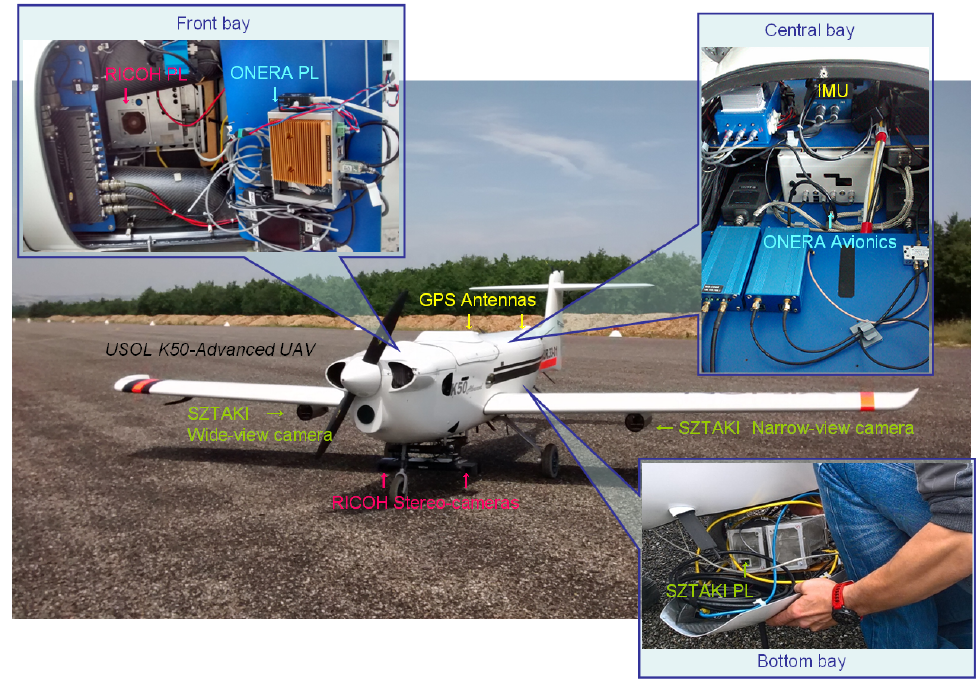
Figure 7. USOL (Spanish SME) K50 UAV experimental platform (60-kg fixed-wing UAV of 4m wing span) with complete sensor and on-board computer setup of the H2020 VISION project [43].